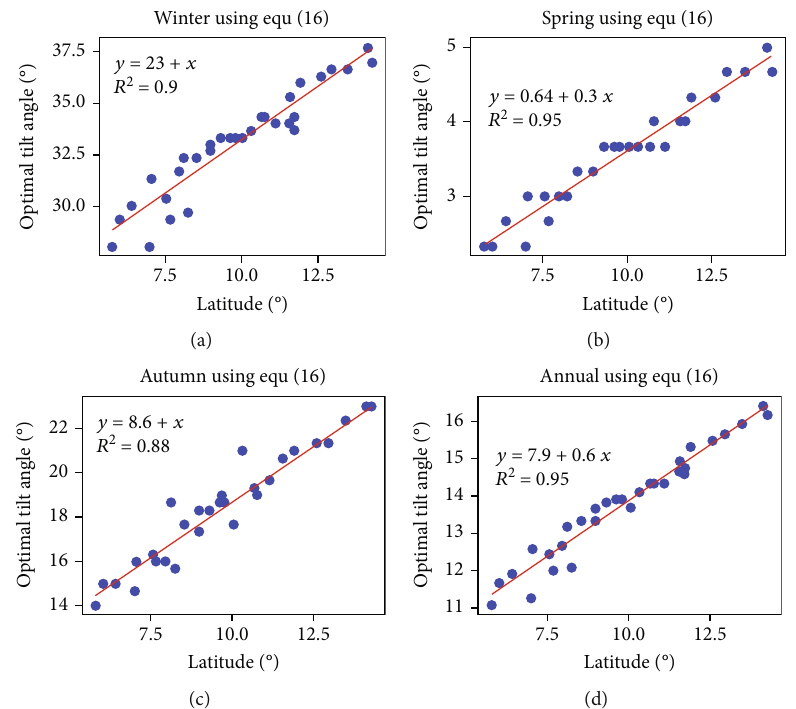
Figure 12: Regression model for seasonal and annual optimal tilt angle using Equation (16).